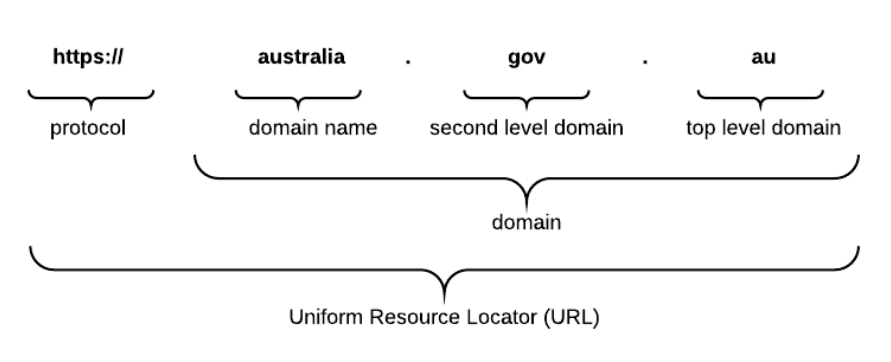
Figure 5. Elements of an